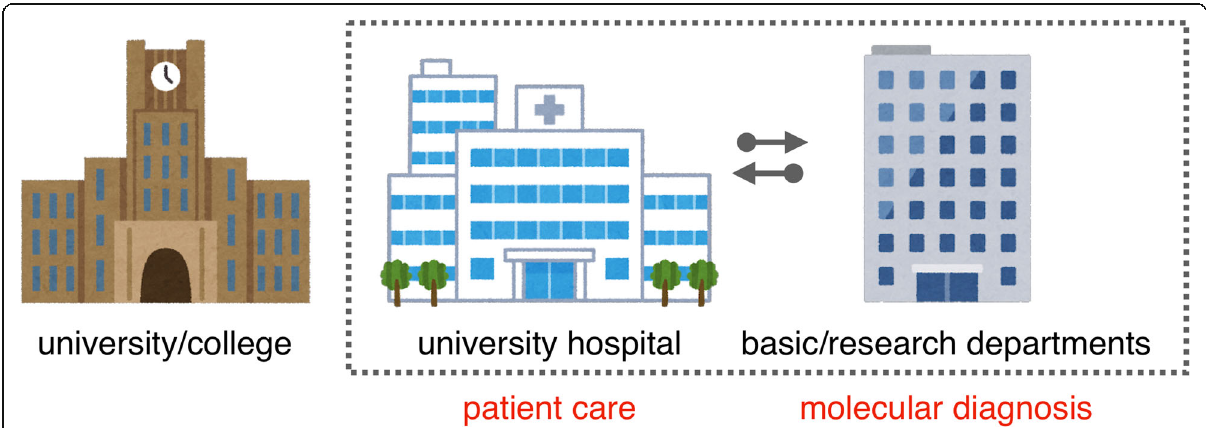
Fig. 1 Schematic illustration of an in-house SARS-CoV-2 RT-PCR-based diagnostic assay in an academic setting, resulting in greatly improved turnaround times. Basic/research departments and institutes of a university, at which their hospital accepts patients in need of care for COVID-19, can be enabled to perform molecular diagnosis using commercial and laboratory-developed tests using research use-only